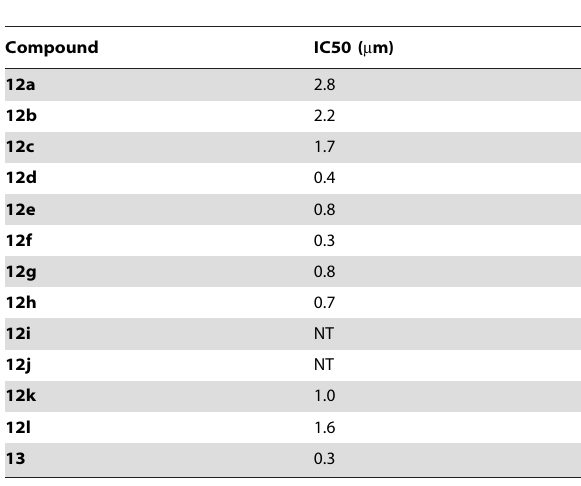
Table 1. IC 50 of the synthesized compounds on Huh-7 colorectal carcinoma cell line.